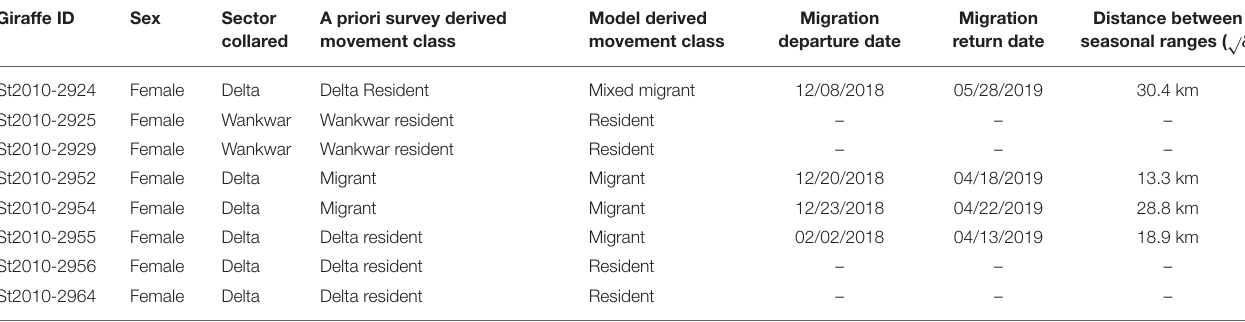
TABLE 1 | Summary of individual giraffe movement categories. Giraffe